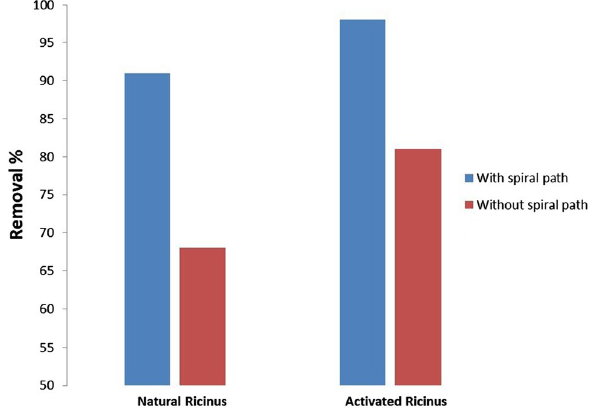
Fig. 10 Removal efficiency of oil emulsion by RC adsorbent in fluid- ized bed with and without spiral path